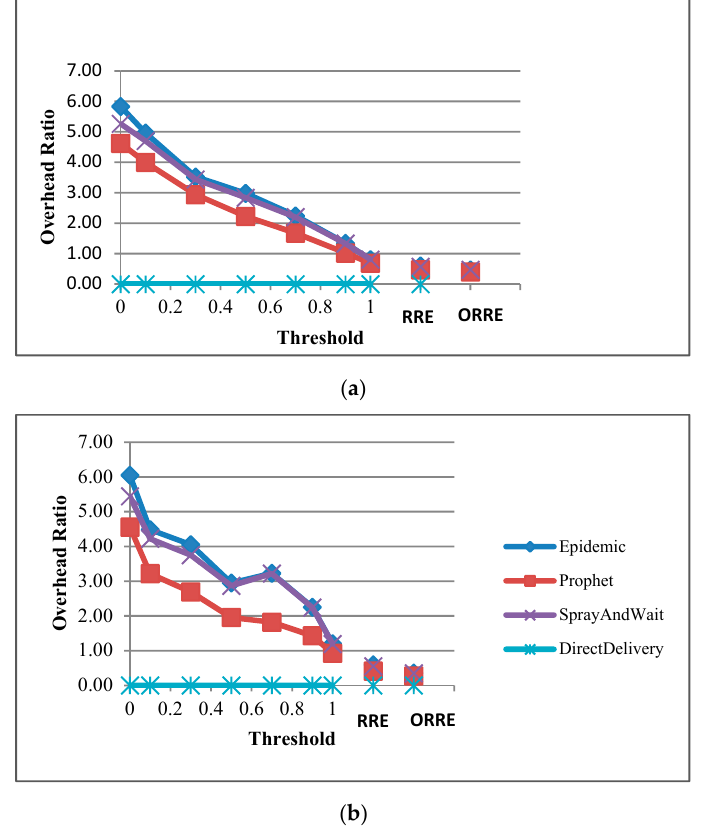
Figure 7. Overhead ratio for Threshold, RRE, ORRE for ( a ) pigeon and ( b ) flying fox scenarios.